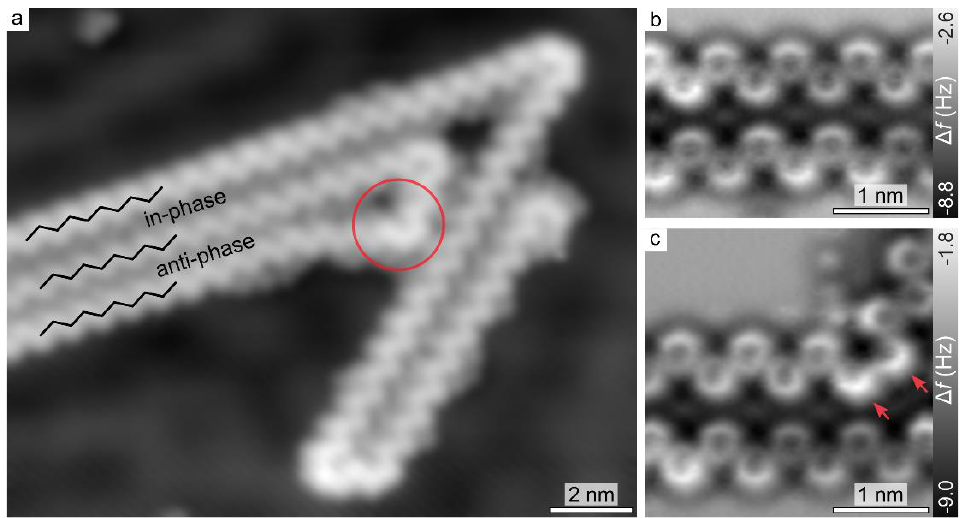
Figure 2. ( a ) Constant-current STM image after annealing to 470 K. Colored circle indicates a kink site. Black lines highlight the local in-phase and anti-phase chain alignment ( I = 2.1 pA, V = 1.0 V). ( b , c ) Constant-height ∆ f AFM images acquired with a CO-functionalized tip at ∆ z = − 1.5 Å, given with respect to an STM setpoint of ( I = 1.5 pA, V = 0.1 V). ( b ) Anti-phase chain alignment. ( c ) Kink site. Arrows indicate the protruding sides of tilted pyridine groups.